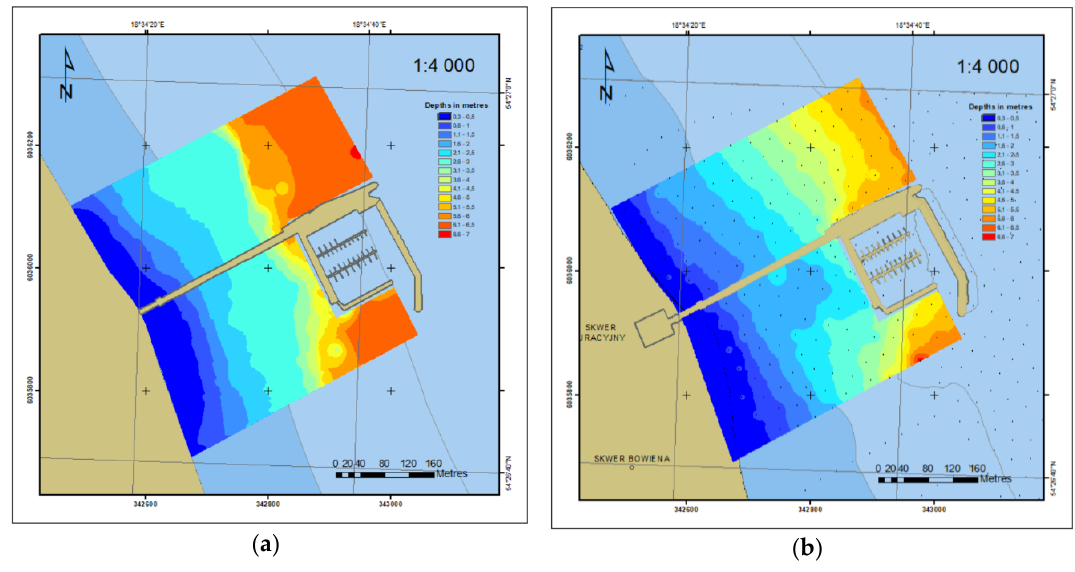
Figure 10. 2D bottom model based on the 2014 ( a ) and 2018 ( b ) ENC data.